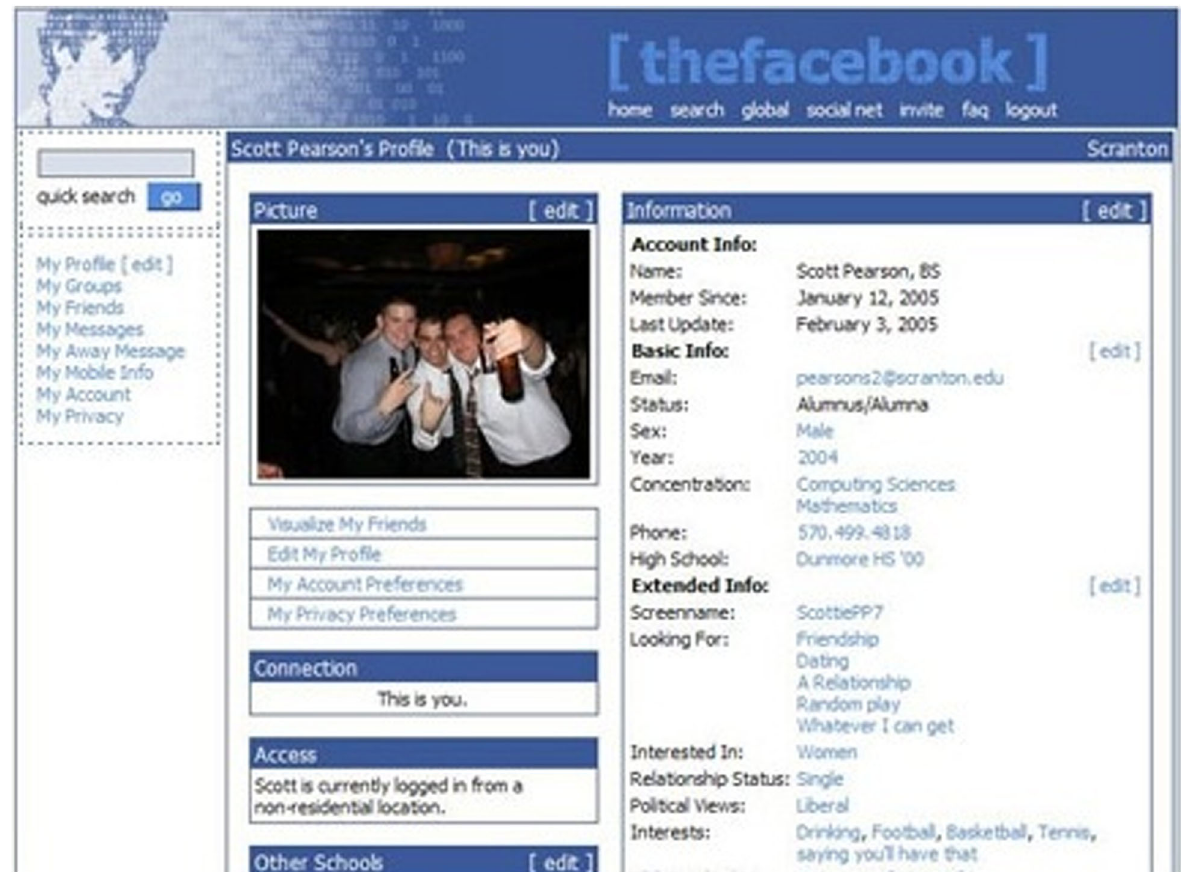
Fig. 1 Early Facebook Screenshot. Early screenshot from “ The Facebook ” indicating its signi fi cant design progression over time.